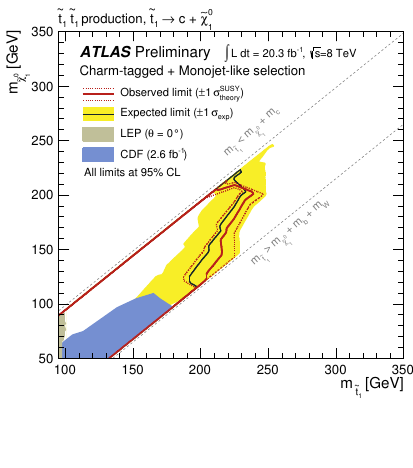
Figure 10: Exclusion plane at 95% CL. as a function of stop and neutralino masses. The ob- served (red line) and expected (black line) upper limits from this analysis are compared to pre- from LEP experiments at CERN with squark mixing angle θ 0 .